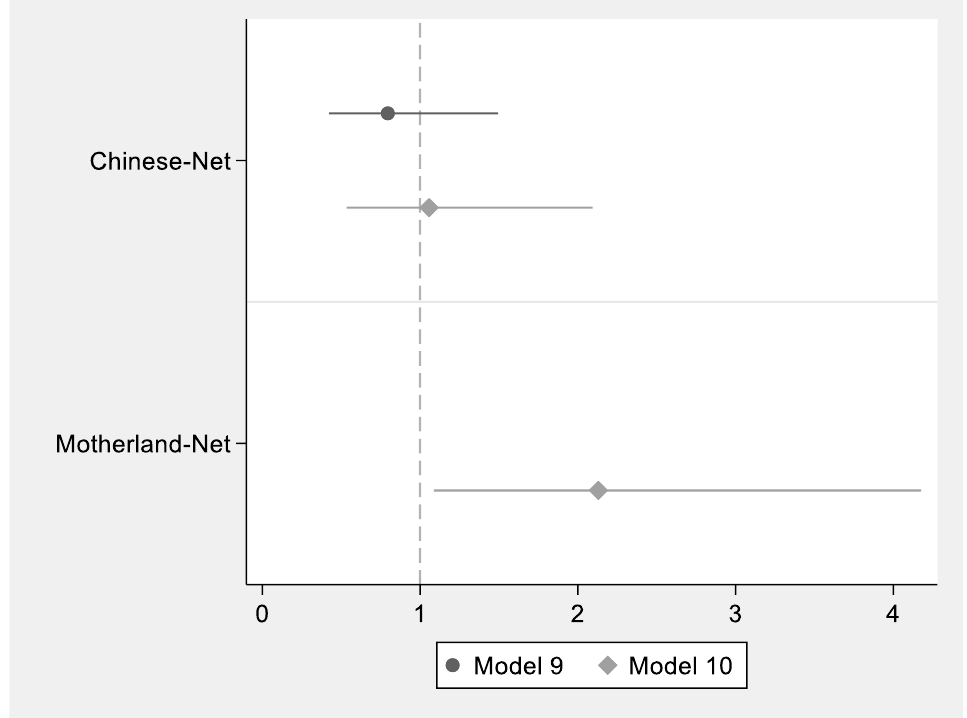
Figure 2. Logistic model for health change analysis of immigrant networks (N = 1624).